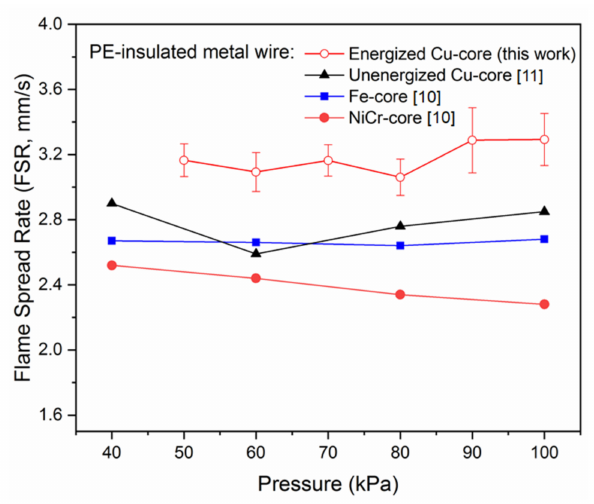
Figure 2. Effects of pressure on the flame spread rate (FSR) along the polyethylene- insulated metal